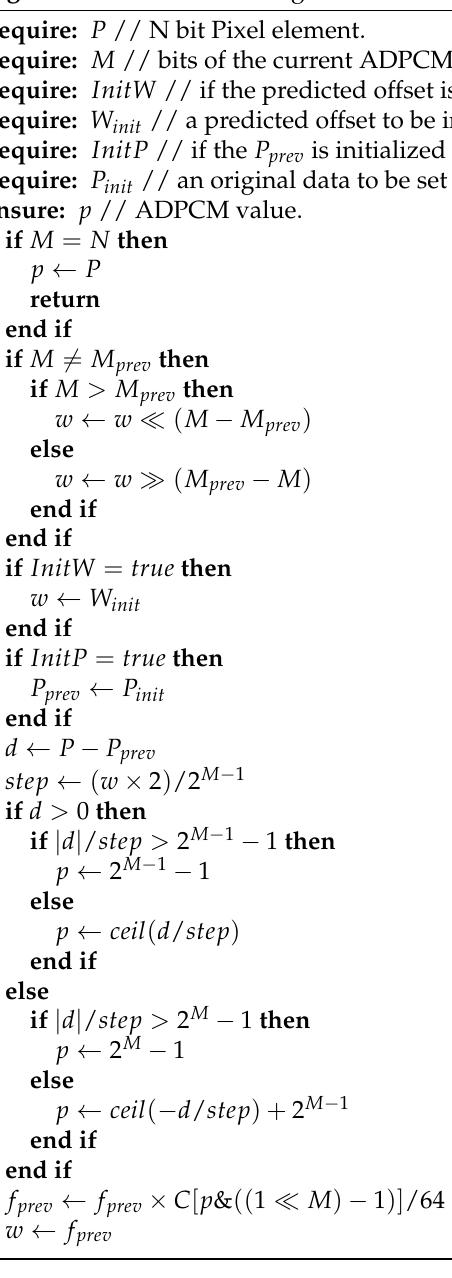
Algorithm 5 Variable bit-length ADPCM